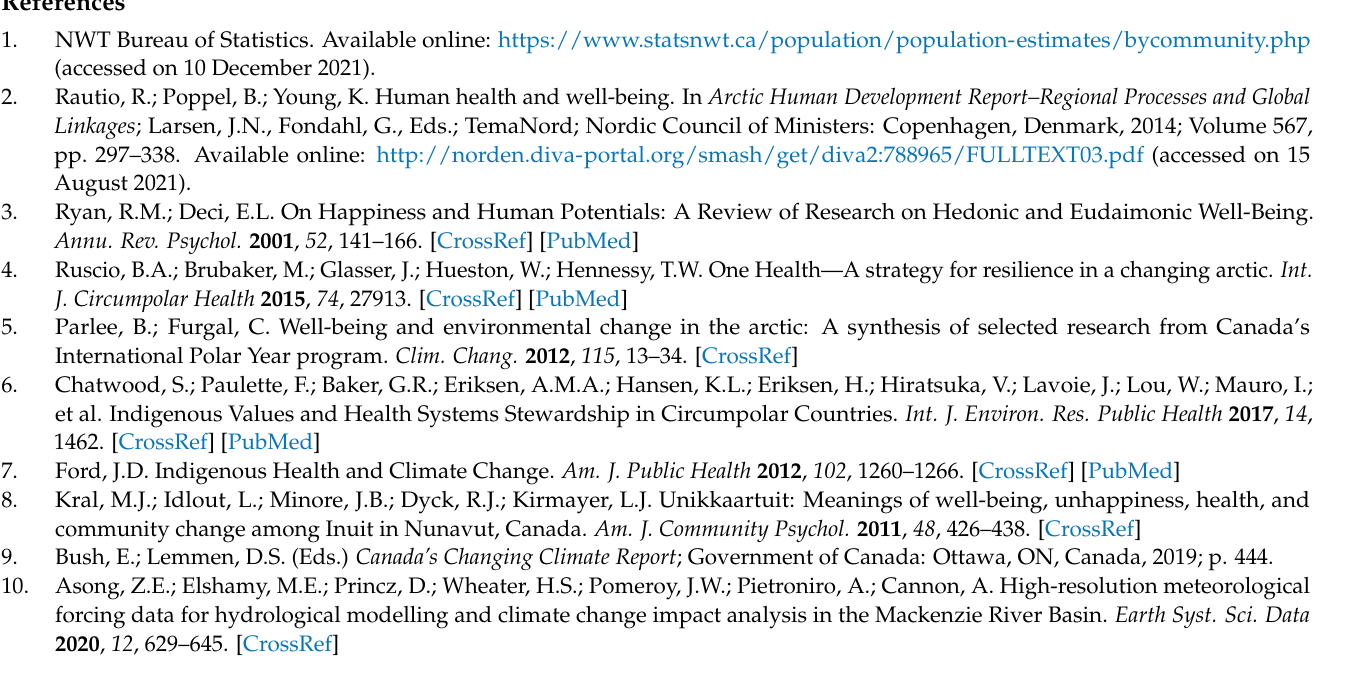
Table S4. Variables of interest (self-rated) and perceived adaptation factors; Table S5. Variables of interest and associations with demographic/perceived environmental factors ( p = <0.1); Table S6. Variables of interest and associations with factors describing specific impacts at the individual and community levels ( p = <0.1); Table S7. Variables of interest and associations with perceived adaptation factors ( p =